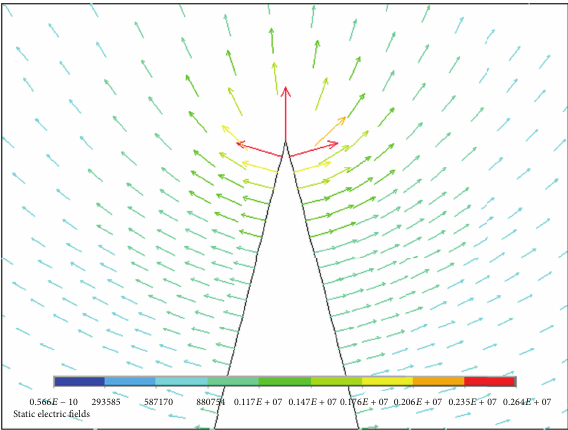
Figure 4: Vector distribution of